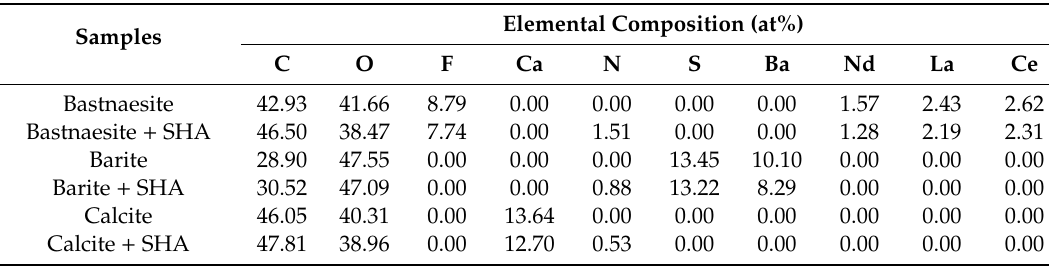
Table 3. Elemental compositions of minerals surfaces, as determined via X-ray photoelectron spectroscopy (XPS).